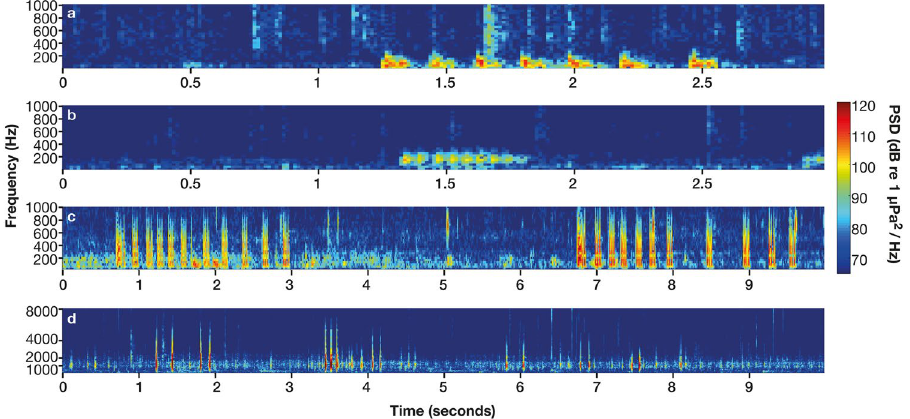
Figure 5. Spectrograms of four different fish species, ( a ) Bluefin gurnard “grunt”, ( b ) John Dory “bark”, ( c ) Bigeye “pops” and ( d ) two spot demoiselle “clicks”, all produced using FFT length = 1024 points, Hanning window and 50% overlap. The colour-bar shows the power spectral density (dB re 1 µ Pa 2 Hz − 1 ). Note the different time and frequency scales.